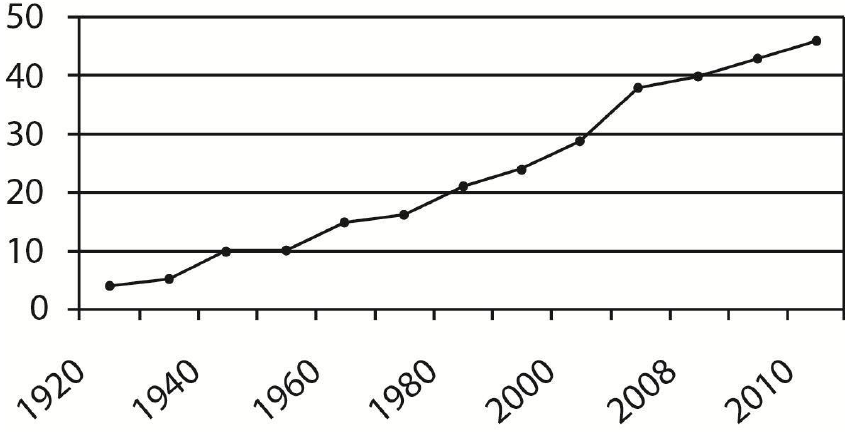
Figure 1. Accredited American SPHs by Decade (compiled by Rosenstock, L. et al